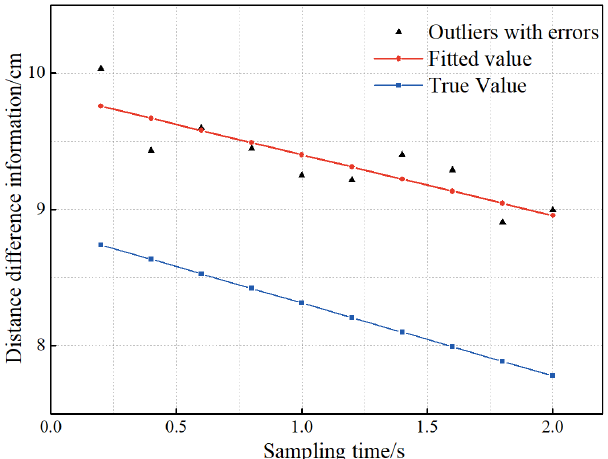
Figure 9. The fitting effect of the polynomial fitting method.